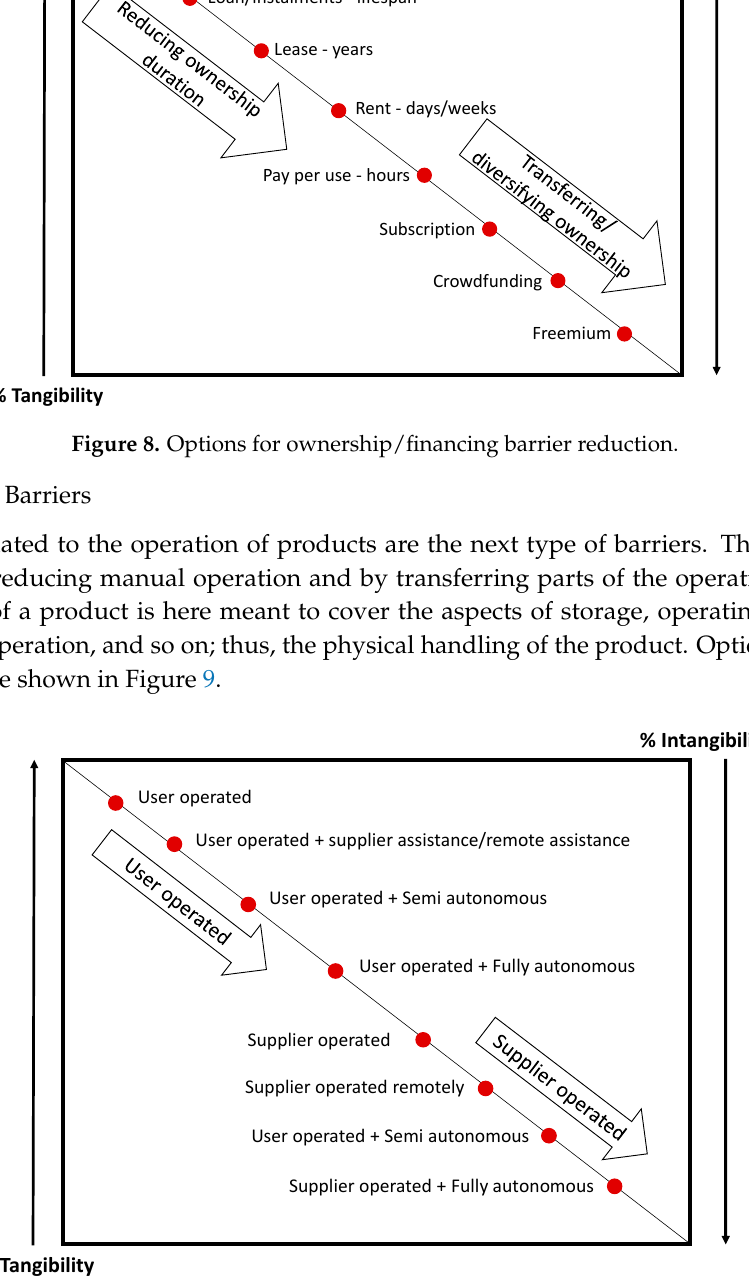
Figure 9. Options for operation barrier reduction.